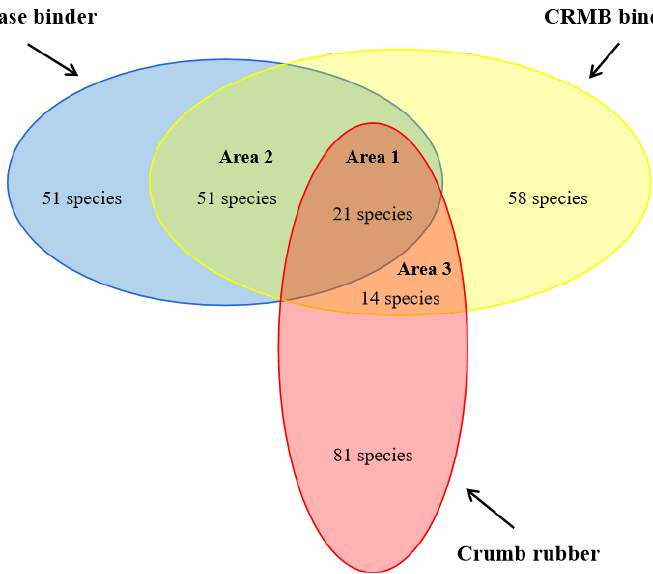
Figure 4. VOCs species overlap for crumb rubber, base, and CRMB binders.